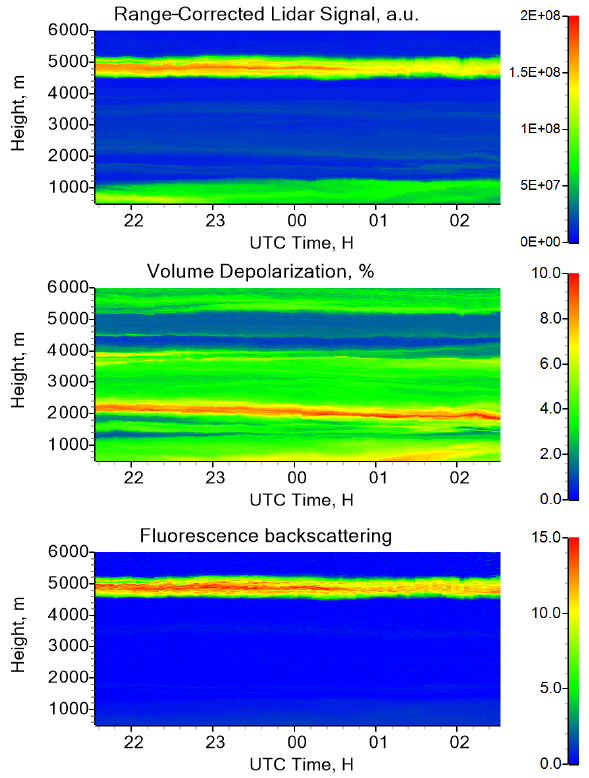
Figure 4. Range-corrected lidar signal at 1064nm, volume depolar- ization ratio at 1064nm and fluorescence backscattering coefficient (in 10 − 4 Mm − 1 sr − 1 ) on 23–24 June